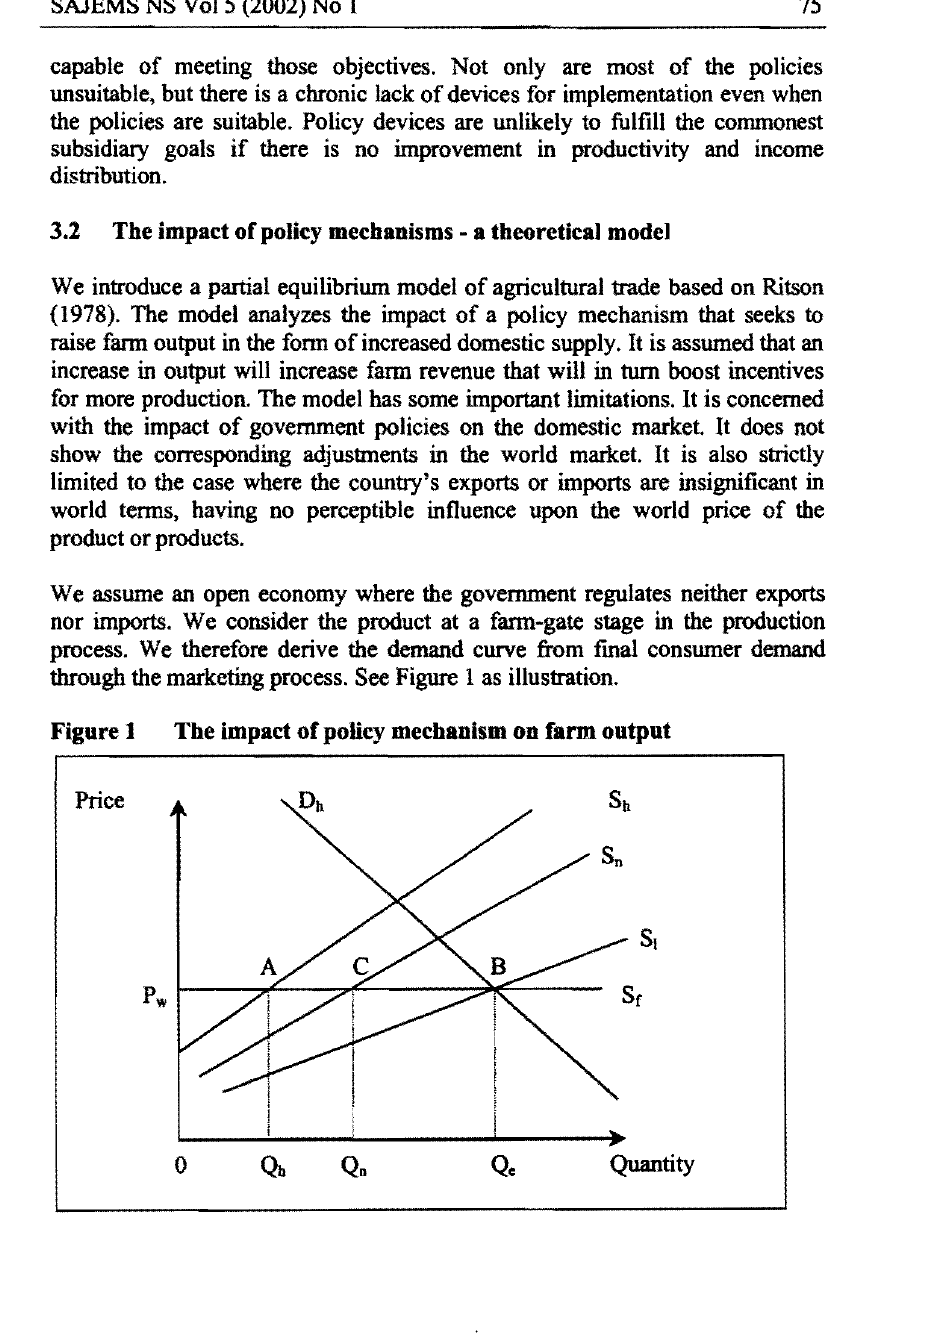
The impact of policy mechanism on farm